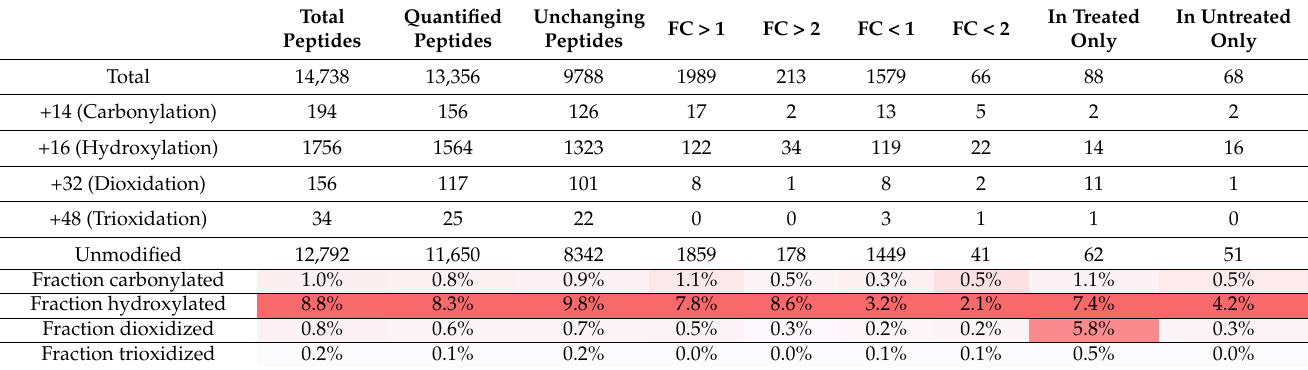
Table 4. Observed peptide oxidation for D. radiodurans (3 kGy:0 Gy) bacterial strain. Total Quantified Unchanging FC > 1 FC > 2 FC < 1 FC < 2 Peptides Peptides Peptides